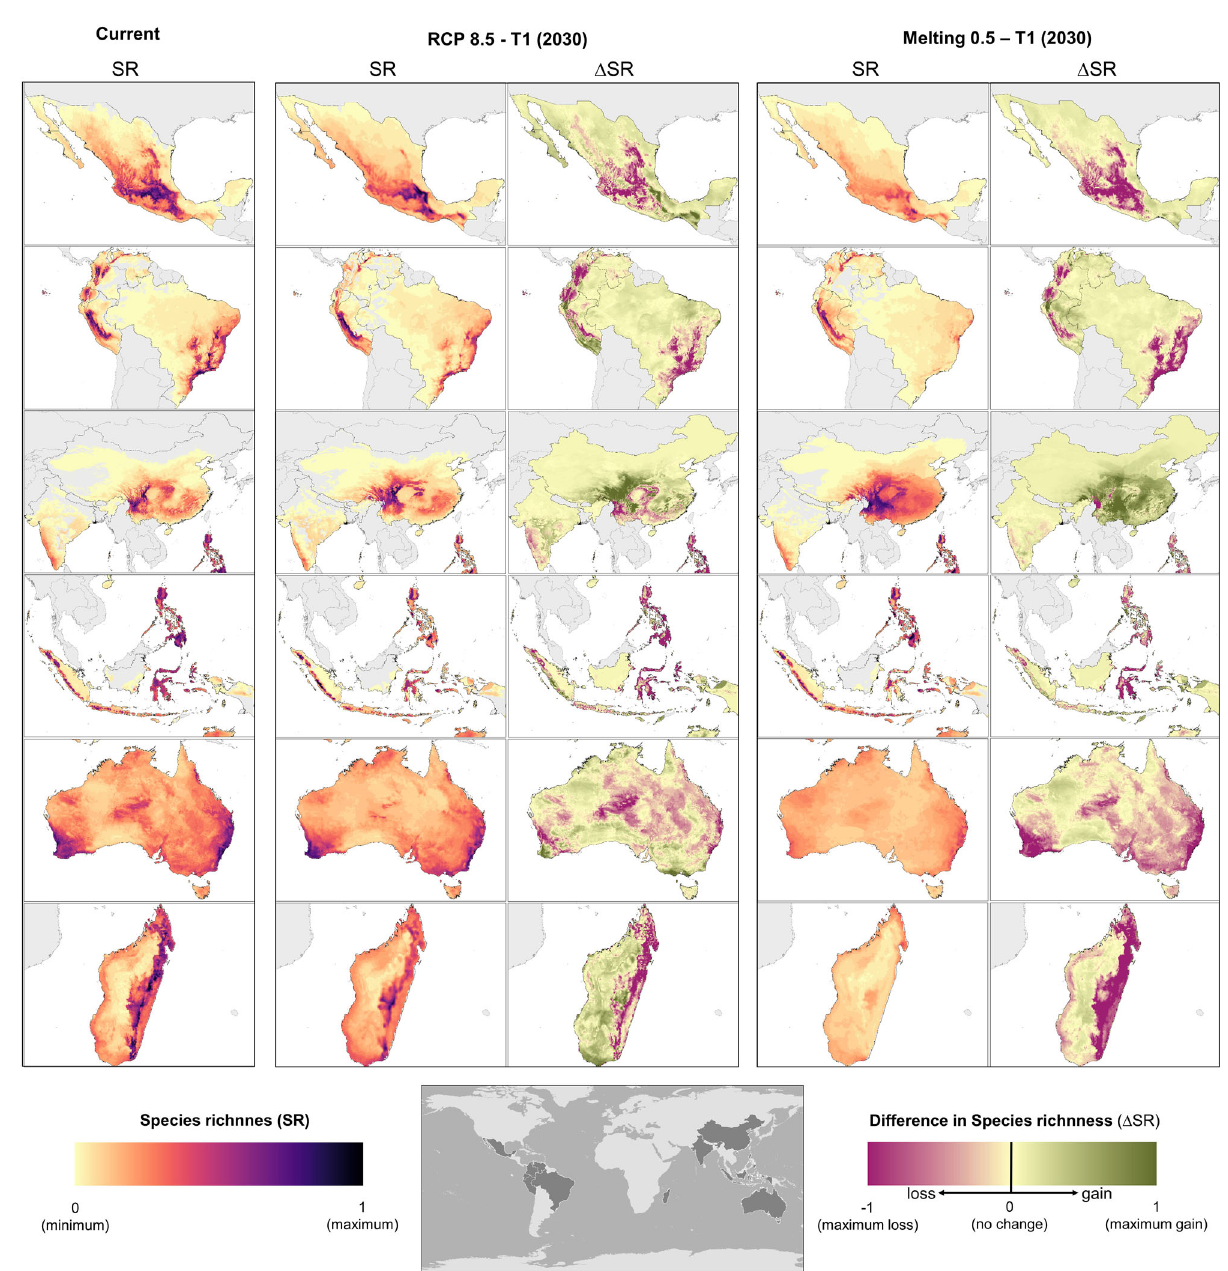
Fig. 6 Geographic patterns of present-day species richness and temporal changes in species richness across twelve megadiverse countries. Estimates are based on species distribution models (SDMs) of vascular plants and tetrapods. Species richness (SR) was standardized to the range 0 – 1 within each country. Differences in species richness ( Δ SR) are shown for T1: 2030 under Melting 0.5 scenario. For each grid cell, the change in species ranges was estimated as the difference in the number of species that fi nd suitable climatic conditions in a speci fi c geographic area and scenario. Please fi nd the separated map for animals and vascular plants in the Supplementary